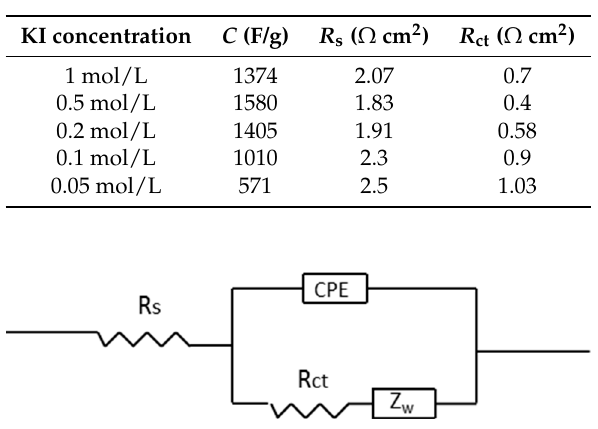
Figure 9. Equivalent circuit for PANI/MnO 2 at different concentrations of KI with 1 M H 2 SO 4 electrolytes.